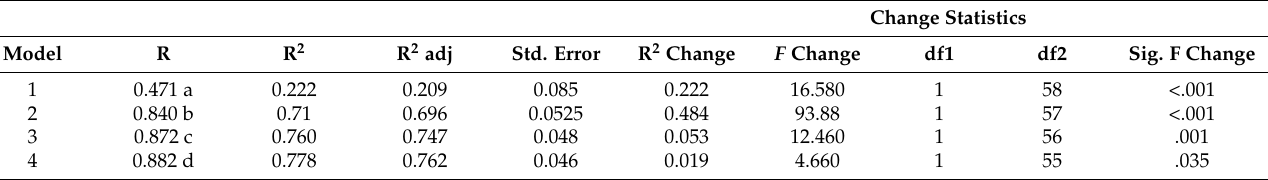
Table A4. Model summary for word accuracy at T3.